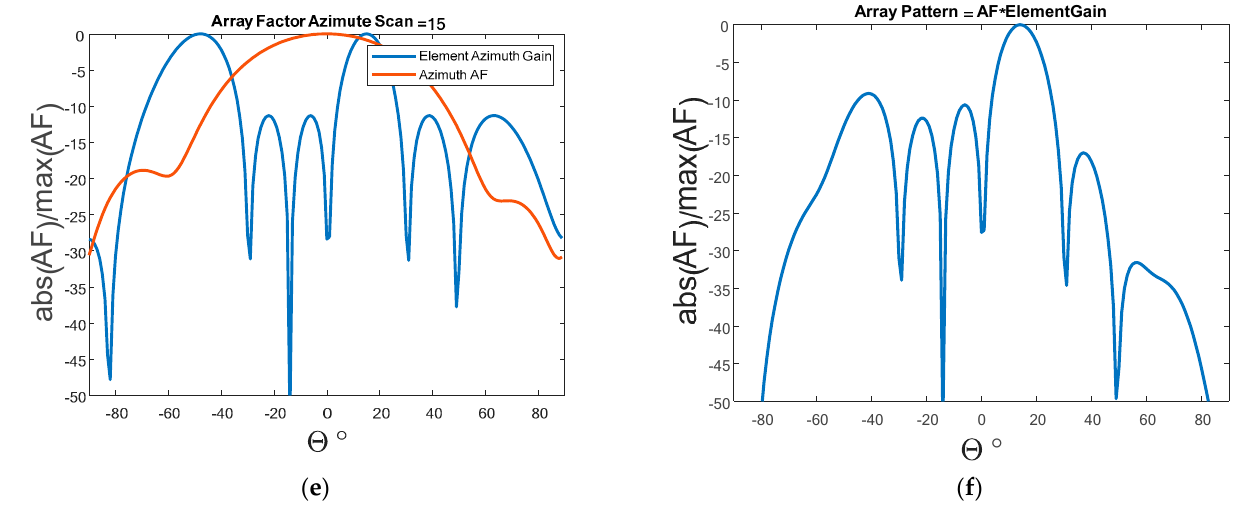
Figure 11. ( a ) Azimuth AF and Element Pattern of a Yagi–Uda array without scanning; ( b ) Azimuth Array Pattern of a Yagi–Uda array without scanning; ( c ) Azimuth AF and Element Pattern of a Yagi–Uda array with azimuth scans of 10 degrees; ( d ) Azimuth Array Pattern of a Yagi–Uda array with azimuth scans of 10 degrees; ( e ) Azimuth AF and Element Pattern of a Yagi–Uda array with azimuth scans of 15 degrees; ( f ) Azimuth Array Pattern of a Yagi–Uda array with azimuth scans of 15 degrees.